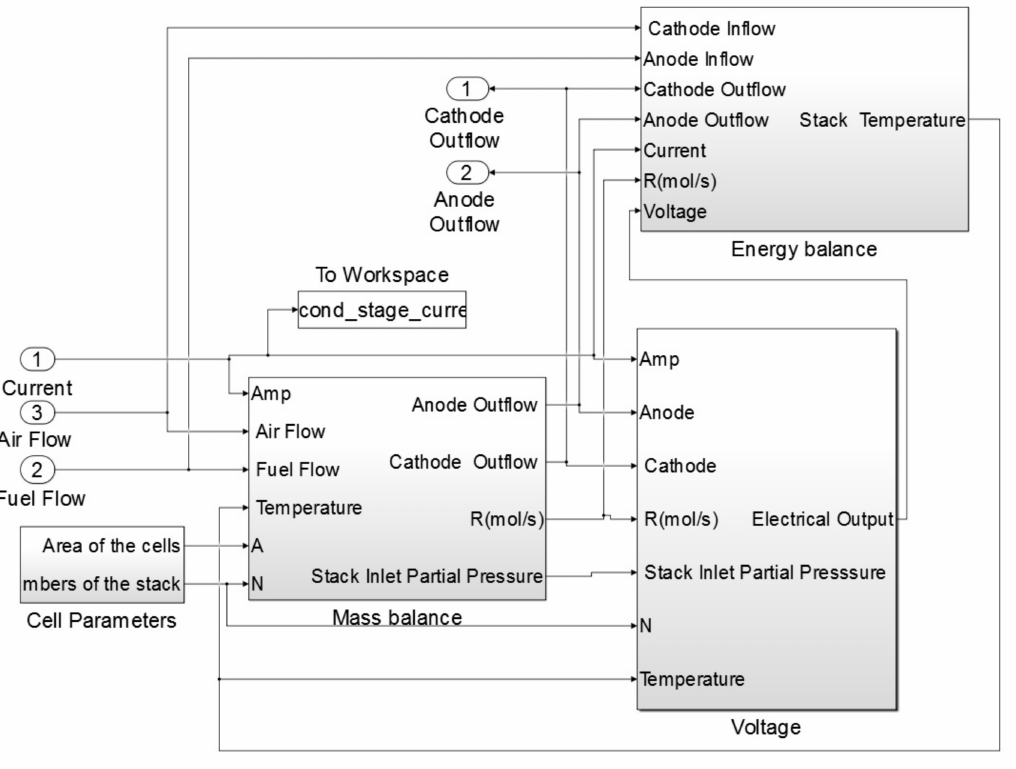
Figure 3. Block diagram of the 1st SOFC stack sub-model.